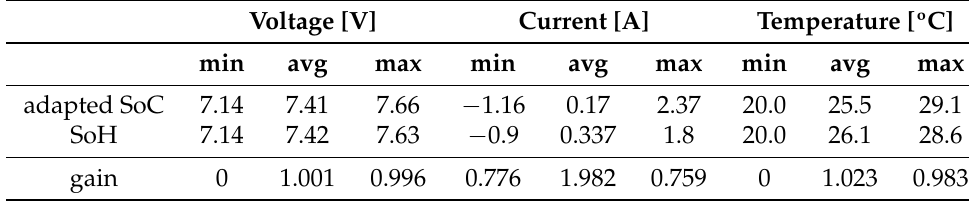
Table 11. Battery 2 during a month of simulation: Case 2.